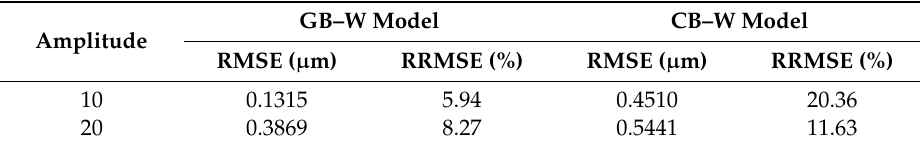
Table 4. Rate-independent modeling errors of the GB–W model and CB–W